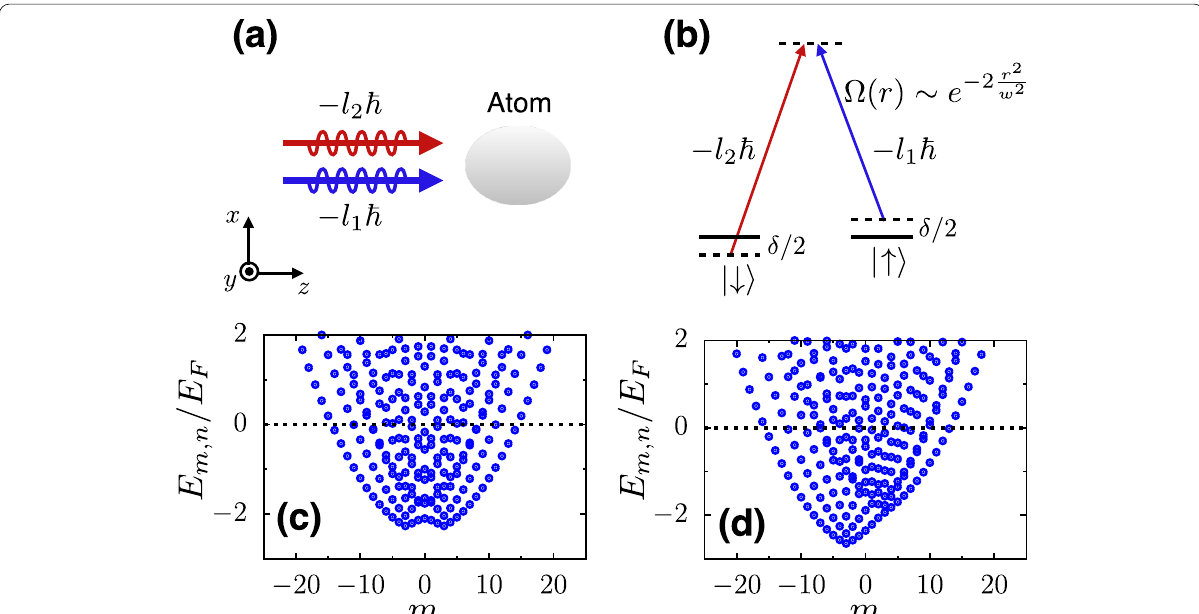
l 1 (cid:31) and l 2 (cid:31) ), − −